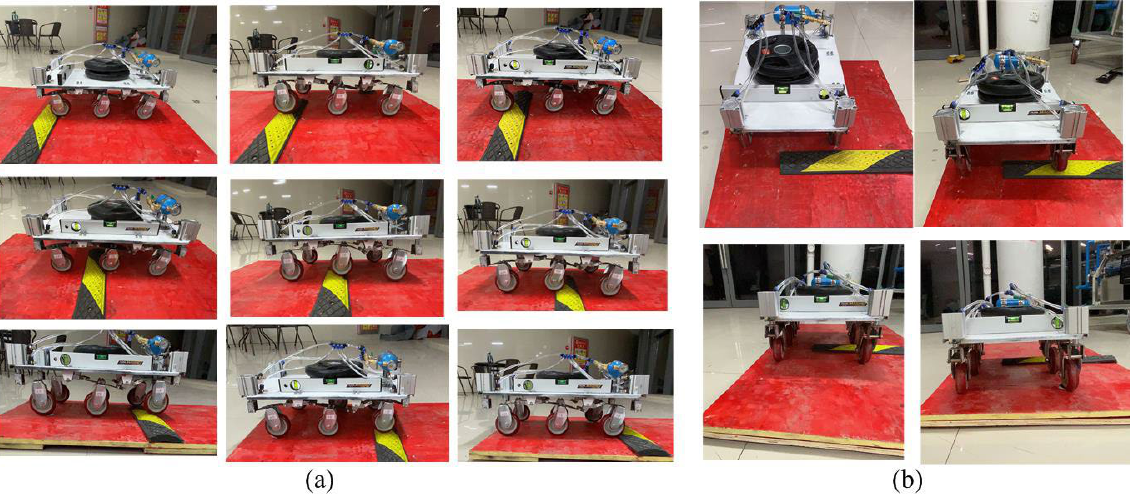
Figure 15. Obstacle crossing tests of unilateral boss in ( a ) longitudinal direction and ( b ) transverse direction.